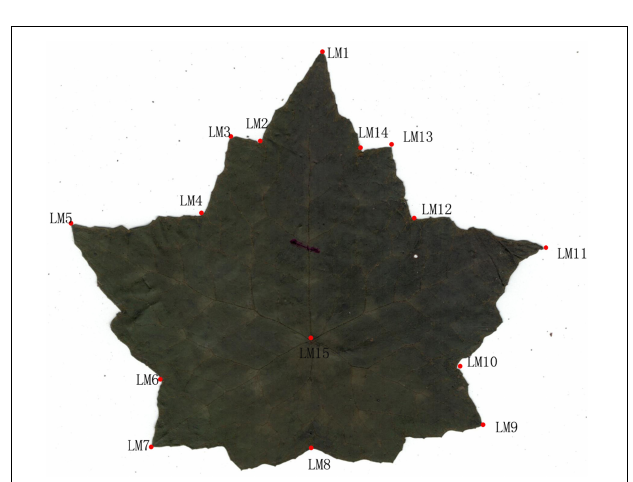
FIGURE 2 | Fifteen landmarks on Asteropyrum